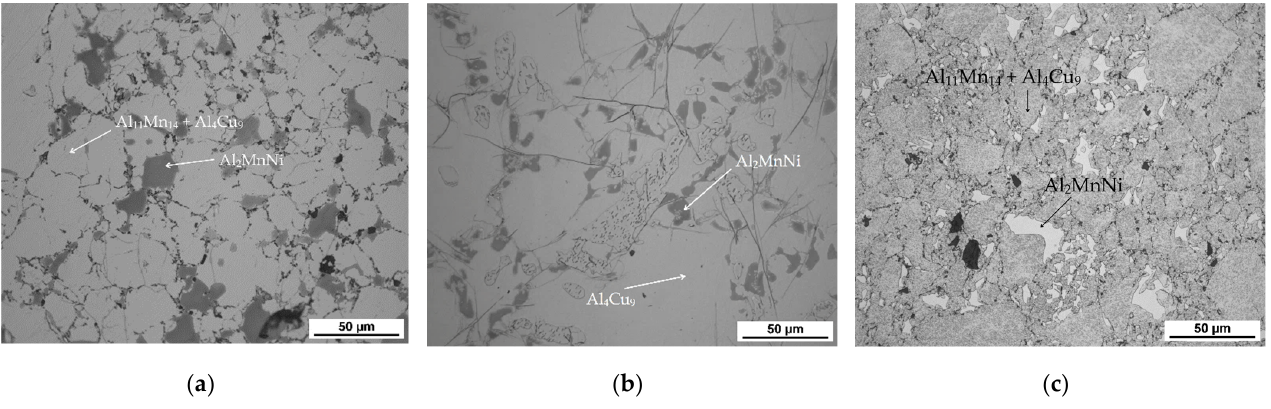
Figure 6. The microstructure of alloy with 100% excess of aluminum over stoichiometry: ( a ) sintered at 900 °C; ( b ) sintered at 950 °C; ( c ) sintered at 900 °C and then heat-treated.